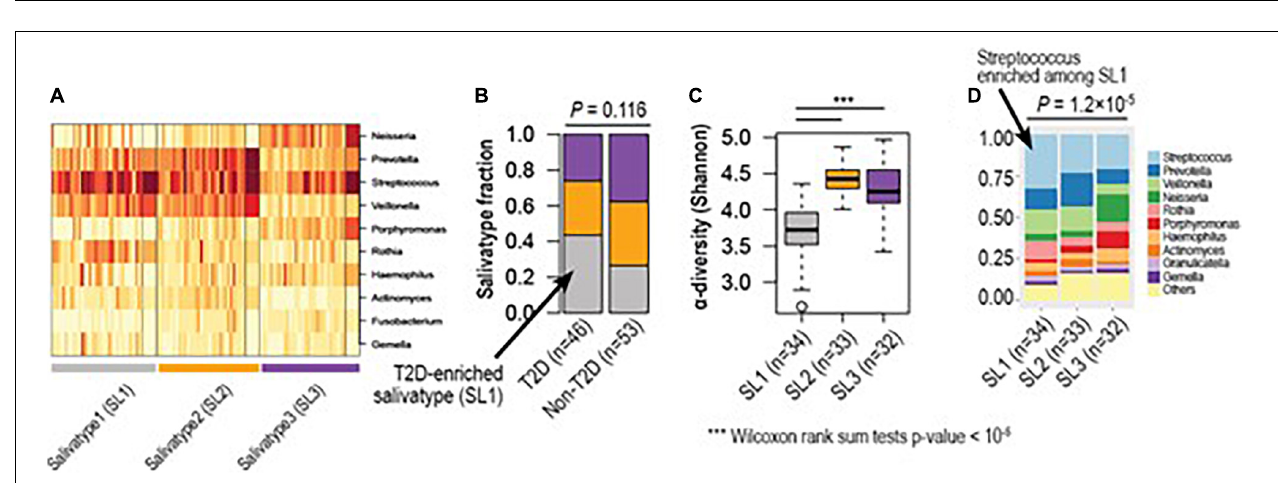
FIGURE 2 | Oral microbiota composition by diabetic status. Based on relative abundance at the genus level, we investigated oral microbiota compositions according to diabetic status. (A) The top-10 most abundant genera of different salivatypes. Genera enriched in non-diabetic (B,C) and diabetic (D,E) subjects (Wilcoxon tests p -values are shown). (F) Correlations of genus abundances with T2D, BMI, and MedDiet status as shown by the MEDAS score (Spearman’s rank correlation).